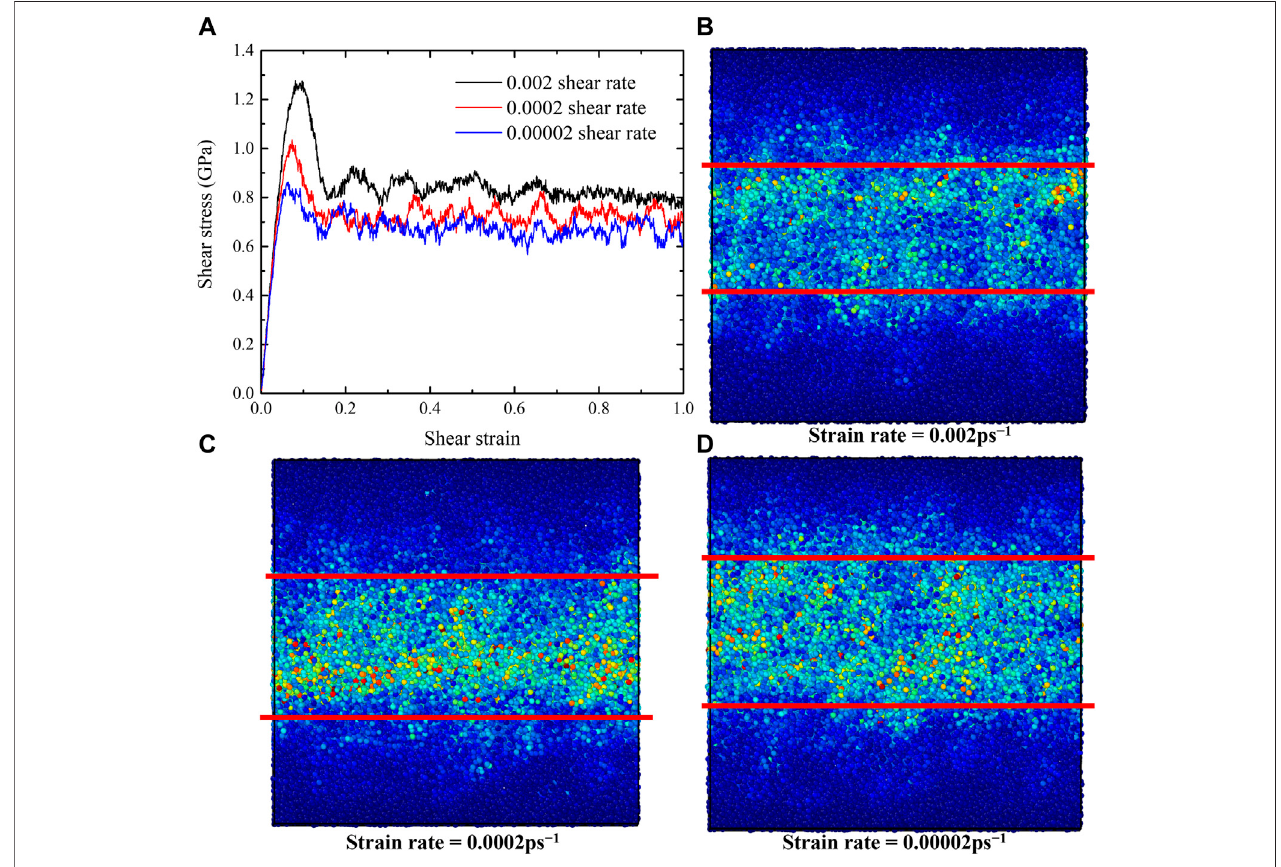
FIGURE 12 | The shear-stress-shear-strain relationships and the atomic von-Mises strain map of L-phase under various strain rates ranging from 0.00002 to 0.002 ps − 1 . (A) The shear-stress-shear-strain relationships, (B – D) the atomicvon-Misesstrainmaps at 0.24shear strainwithdifferent strainratesof (B) 0.002 ps − 1 , (C) 0.0002 ps − 1 , and (D) 0.00002 ps − 1